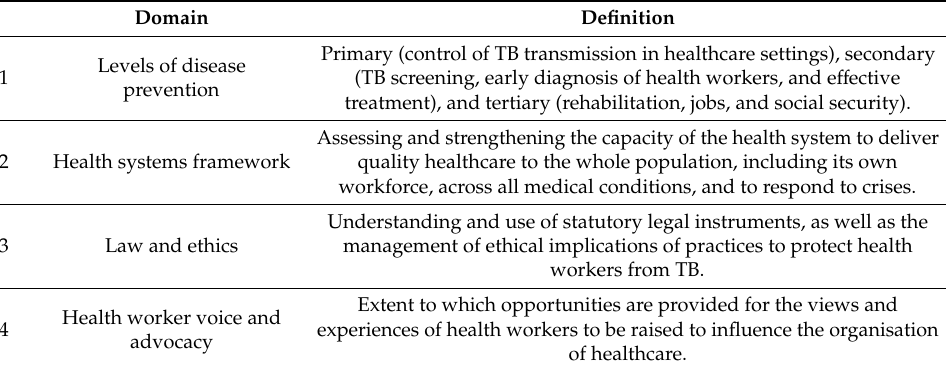
Table 1. Components of a comprehensive occupational health approach to the protection of health workers from occupational tuberculosis (TB).